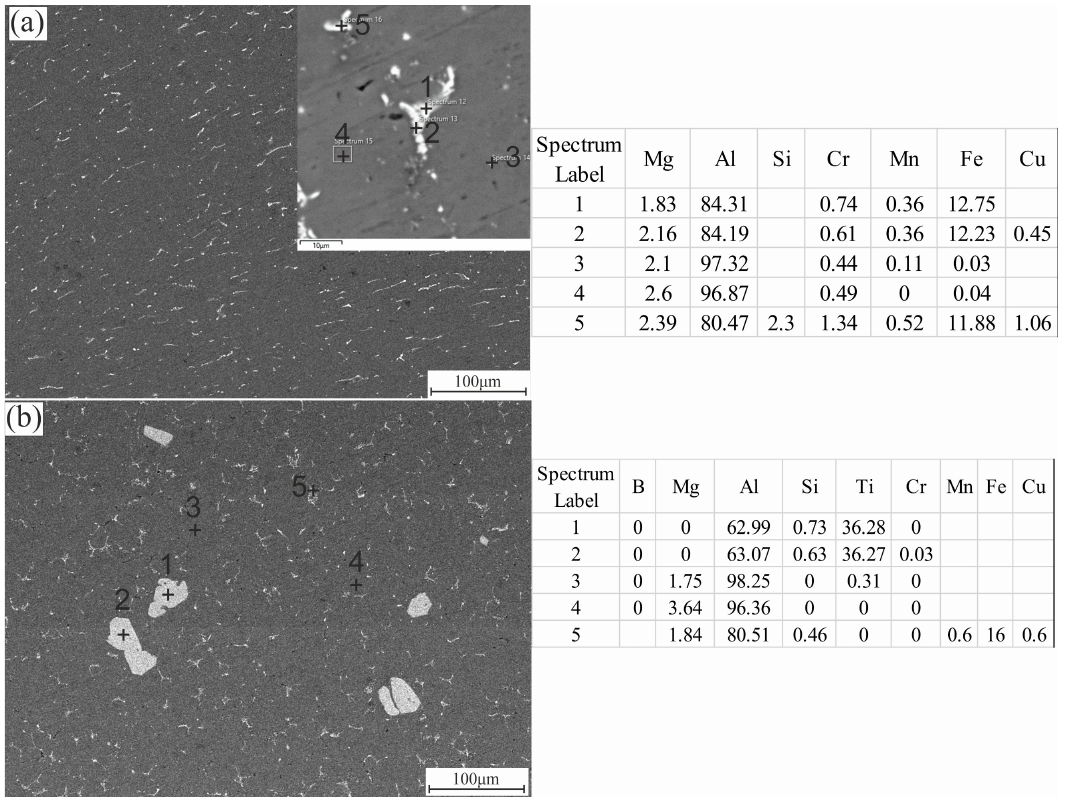
Figure 3. The as-cast SEM and EDS analysis of ( a ) Al 5052 and ( b ) Al 5052/TiB alloys (all values are in wt%).